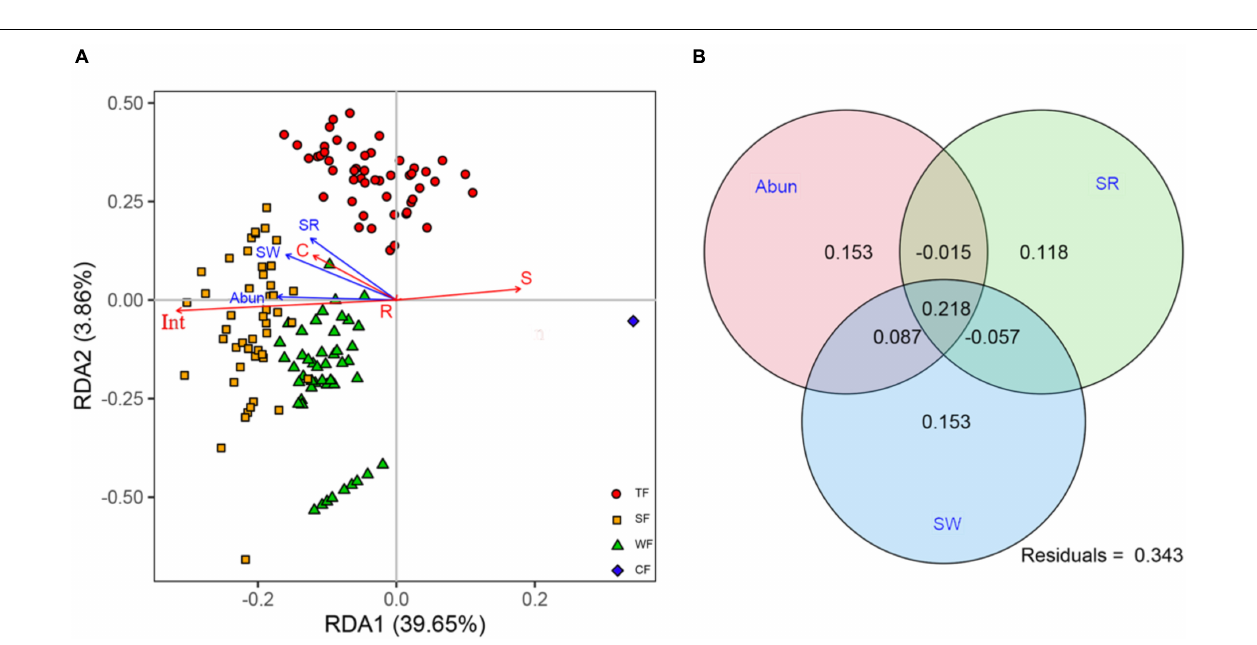
FIGURE 2 | Relationship between ecological strategy group (i.e., C-, S-, and Int-groups) and diversity: species abundance (Abun; A–C ), species richness (SR; D–F ), Shannon-Wiener index (SW; G–I ). Symbols in different colors and shapes indicate different forest types: TF, tropical forest (red circles); SF, subtropical forest (yellow squares); WF, warm-temperate forest (green triangles); and CF, cold-temperate forest (blue diamonds). Black lines indicate significant associations ( P < 0.05).